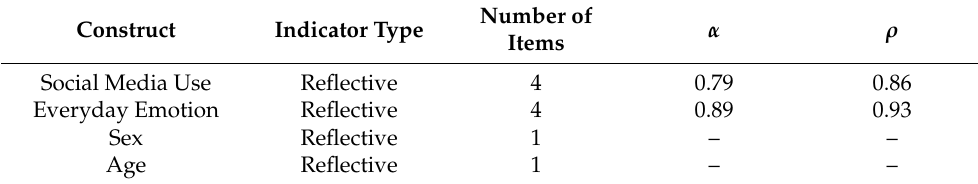
Table 5. Unidimensionality of indicators for each latent construct.